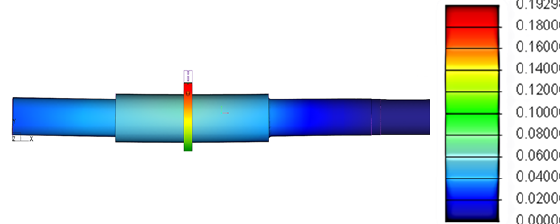
Figure 11 Total deformation of the shaft and the crushing